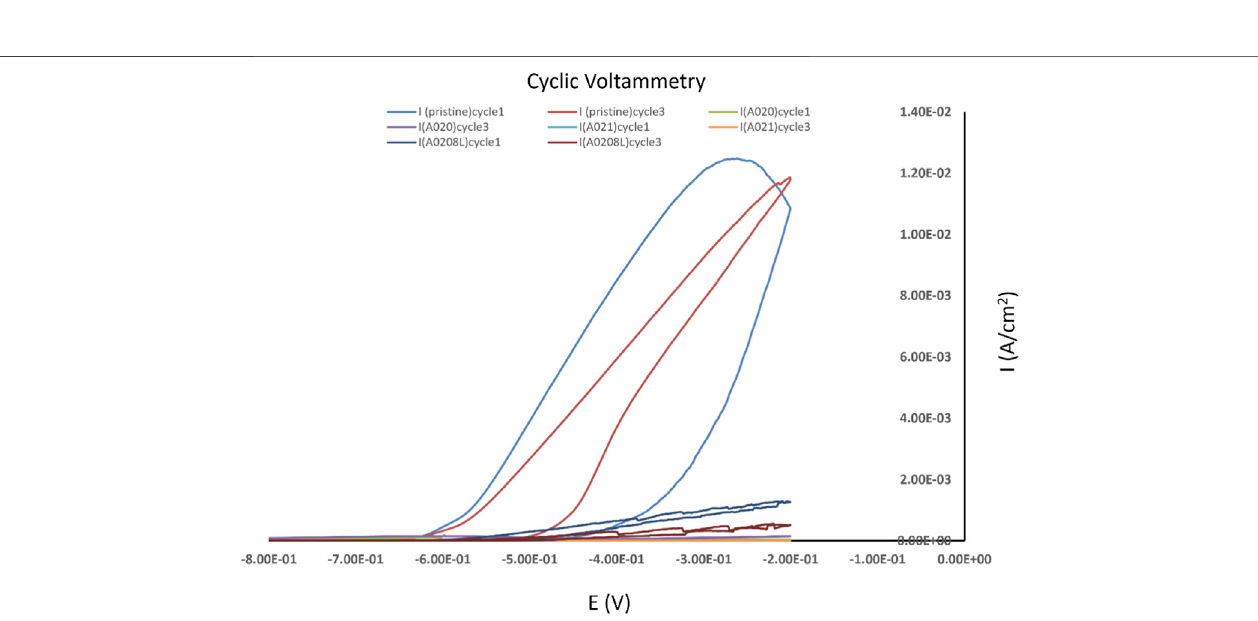
Frontiers in Materials |